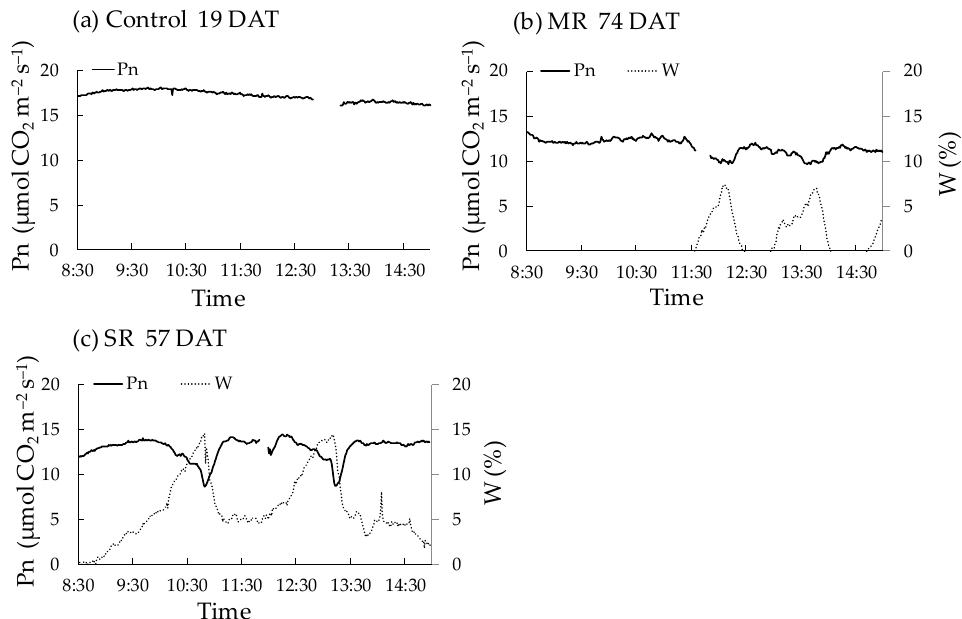
Figure 5. Typical diurnal changes in the net photosynthetic rate (Pn) and wilting ratio (W) in the control ( a ), MR ( b ), and SR ( c ) from 08:30 to 15:00 on a sunny day. DAT: days after commencing treatments; MR: moderate wilting–full recovery treatment; SR: severe wilting–full recovery treatment.